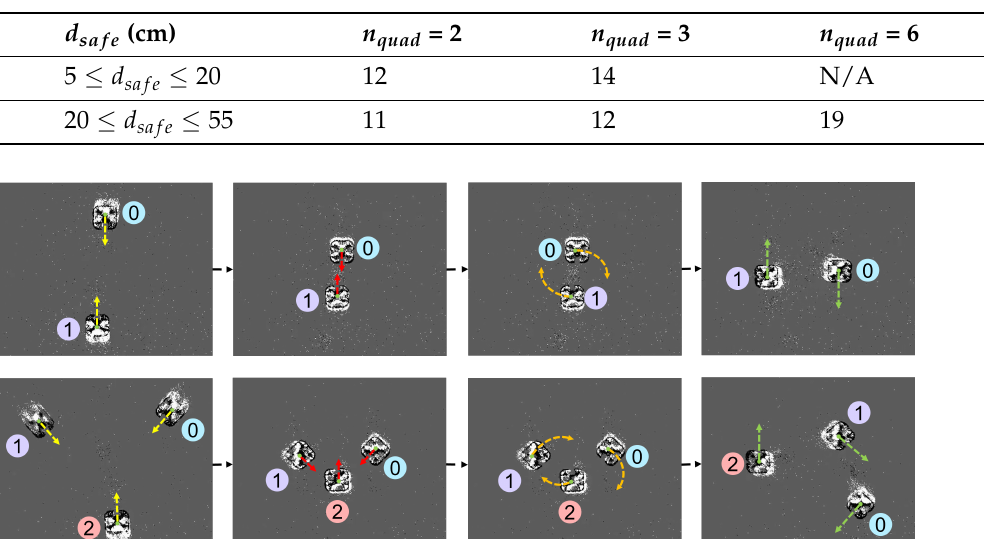
Table 2. Average T mission (and rounded to zero decimals) in seconds for varying d safe and n quad for indoor experiments.